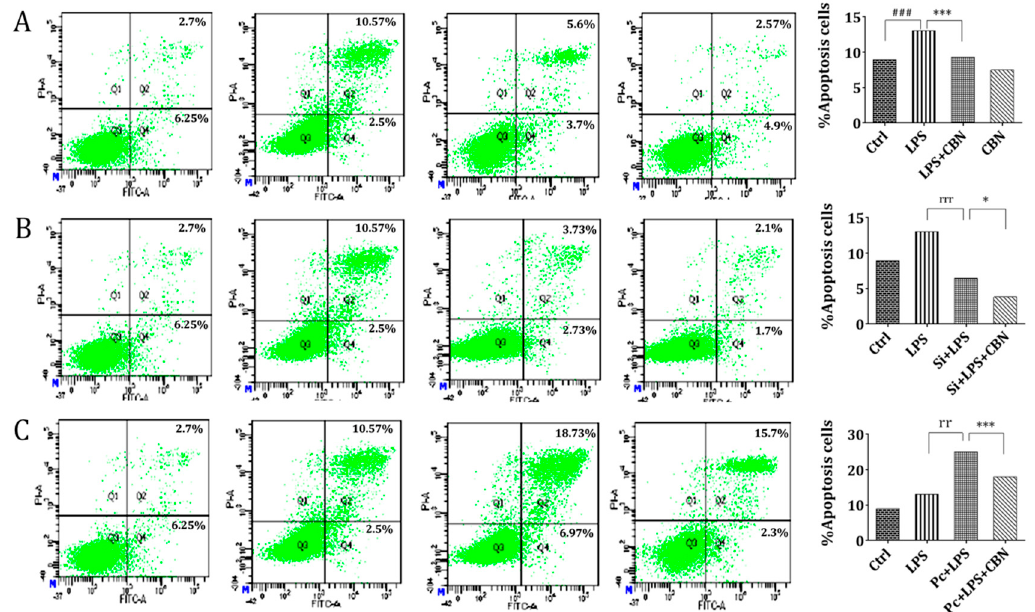
Figure 5. Effect of CBN on apoptosis in LPS-induced THP-1 cells. Cells were stimulated by LPS for 24 h, then incubated with indicated doses of CBN for 24 h. Annexin V/PI staining was used for apoptotic cells. Q1 represents dead cells, Q2 represents nonviable apoptotic cells, Q3 represents normal cells, and Q4 represents viable apoptotic cells. ( A ) CBN restrained LPS-induced THP-1 cell apoptosis. ( B ) The inhibiting effect of CBN on apoptosis was weakened after NOD1 siRNA transfection in THP-1 cells. ( C ) CBN showed a remarkable restrictive effect on apoptosis again after pcDNA-NOD1 transfection in THP-1 cells. ### P < 0.001 LPS group versus control group; * P < 0.05 drug group versus LPS group; *** P < 0.001 drug group versus LPS group; rr P < 0.01 Pc + LPS versus LPS group; rrr P < 0.001 si + LPS versus LPS group. The results shown are representative of three independent experiments with similar results. Data are expressed as means ± SD.